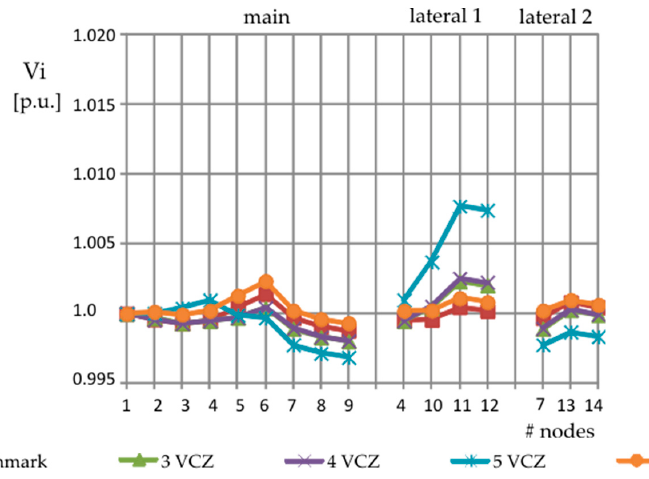
Figure 17 : Voltage profiles for Case X — DG and BESSs: Q algorithm—feeder 1.